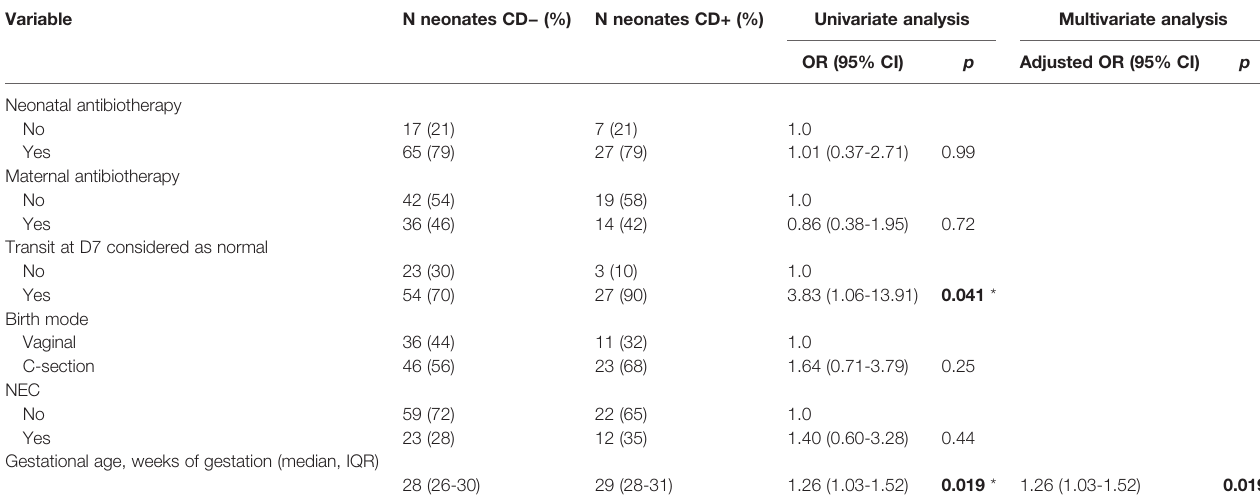
TABLE 3 | Factors associated with C. dif fi cile colonization in the ClosNEC cohort.